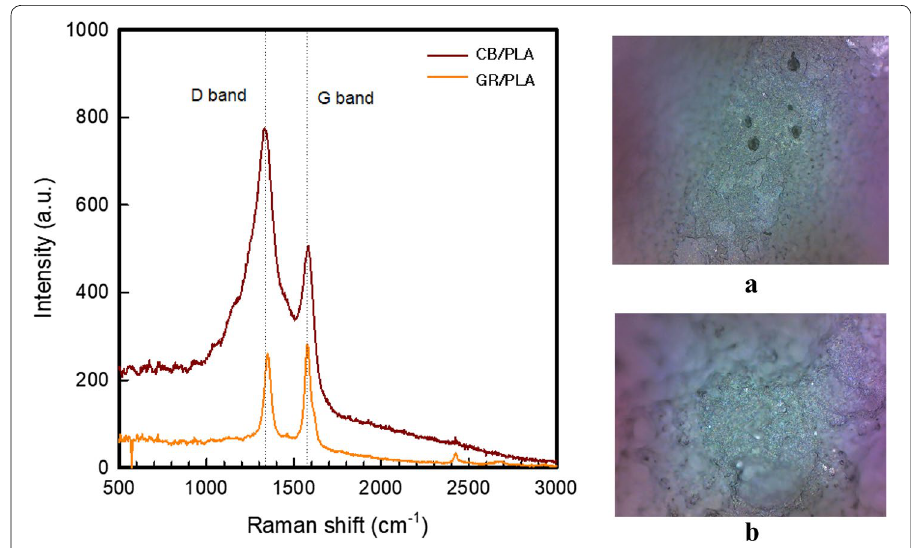
Fig. 4 Raman spectra and images of a carbon black/PLA and b graphene/PLA filaments for 3D